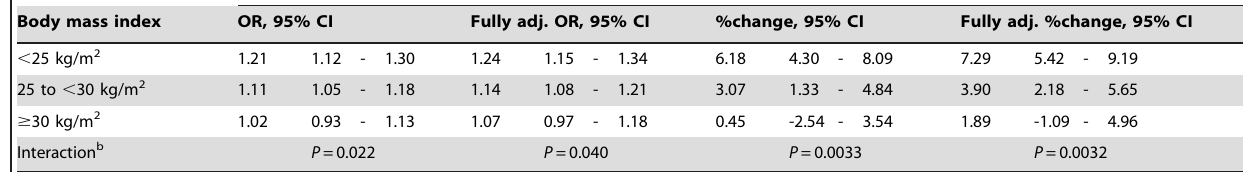
Table 5. Regression of c -GT and smoking, by body mass index category.